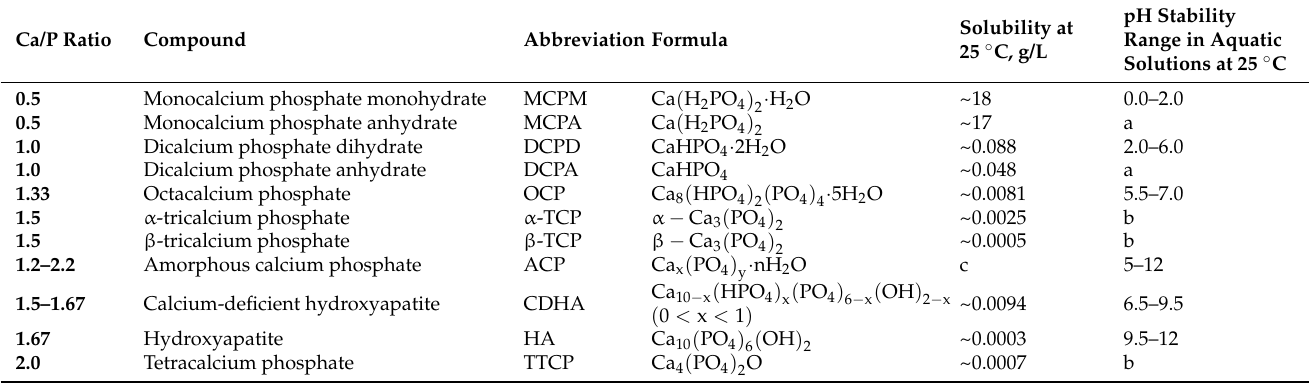
Table 2. A list of the calcium orthophosphates and their major properties [87,88].